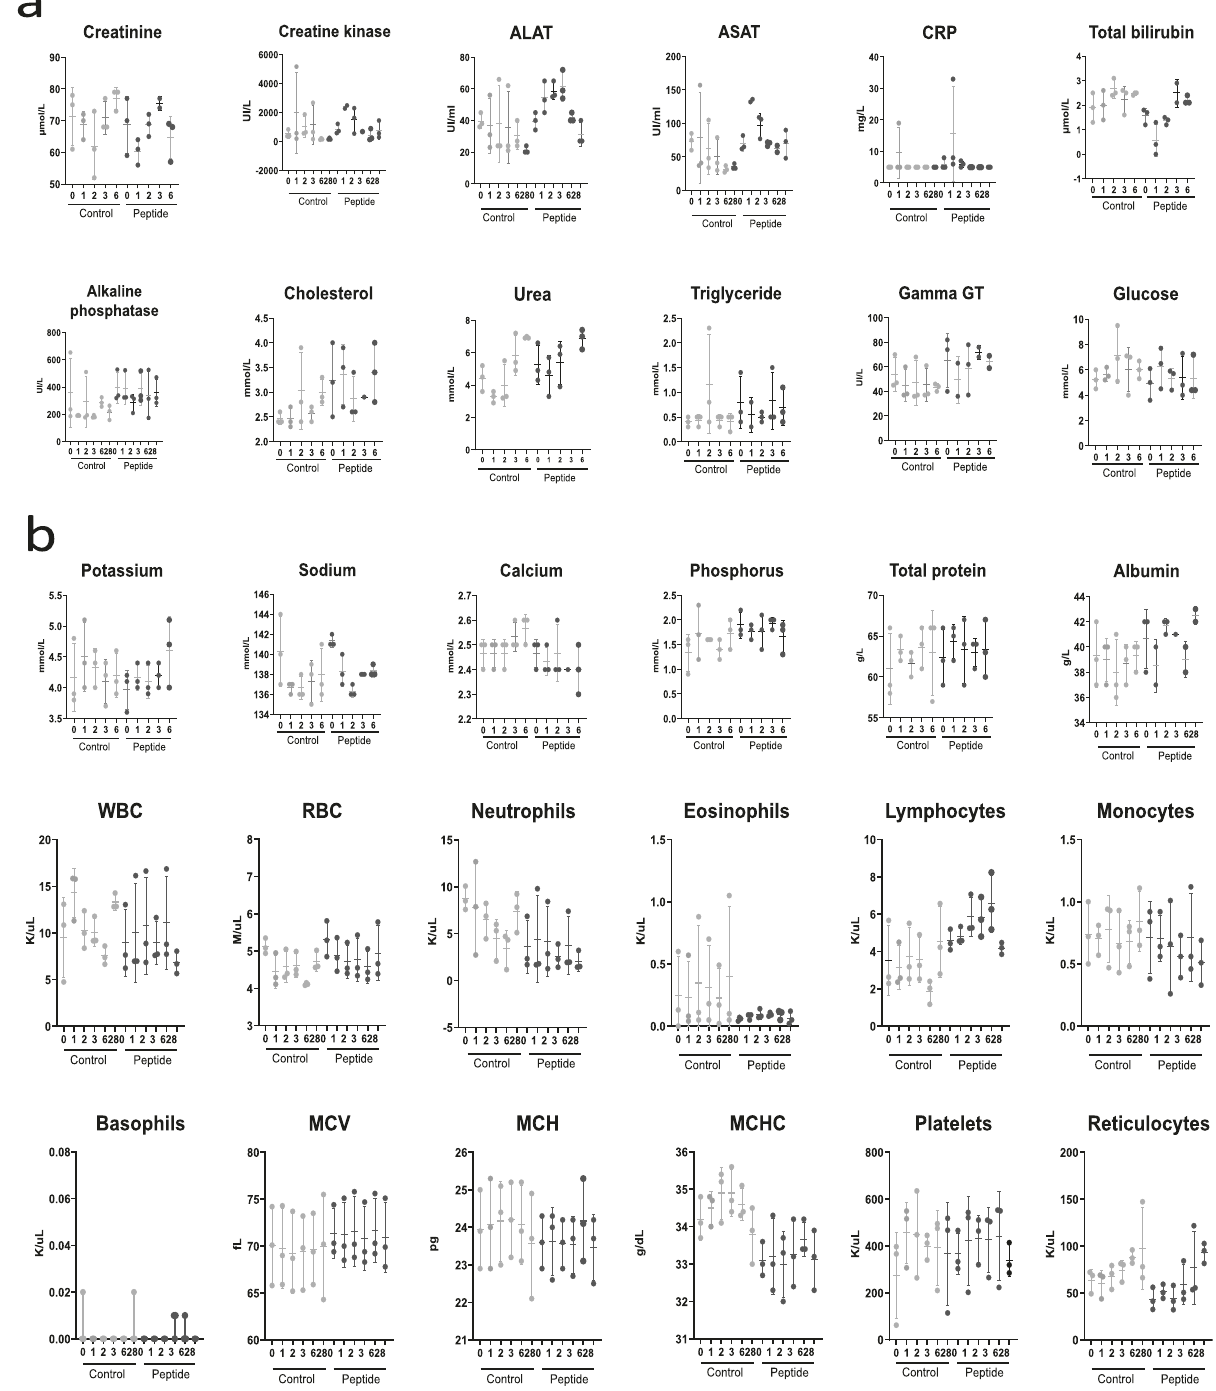
Fig. 4 | Evolution of biochemical and haematological parameters in the blood cynomolgus monkeys following the nebulization of either saline (control) or HRC4 (peptide).a Concentration of indicatedbiochemicalparametersinblood of monkeys, measured on days 0, 1, 2, 3, 6 and 28 after nebulization of either saline solution (0.9%NaCl, n =3) or HRC4 peptide (4mg/kg, n =5); b Haematological parameters measured at days 0, 1, 2, 3, 6 and 28 after nebulisation of either saline